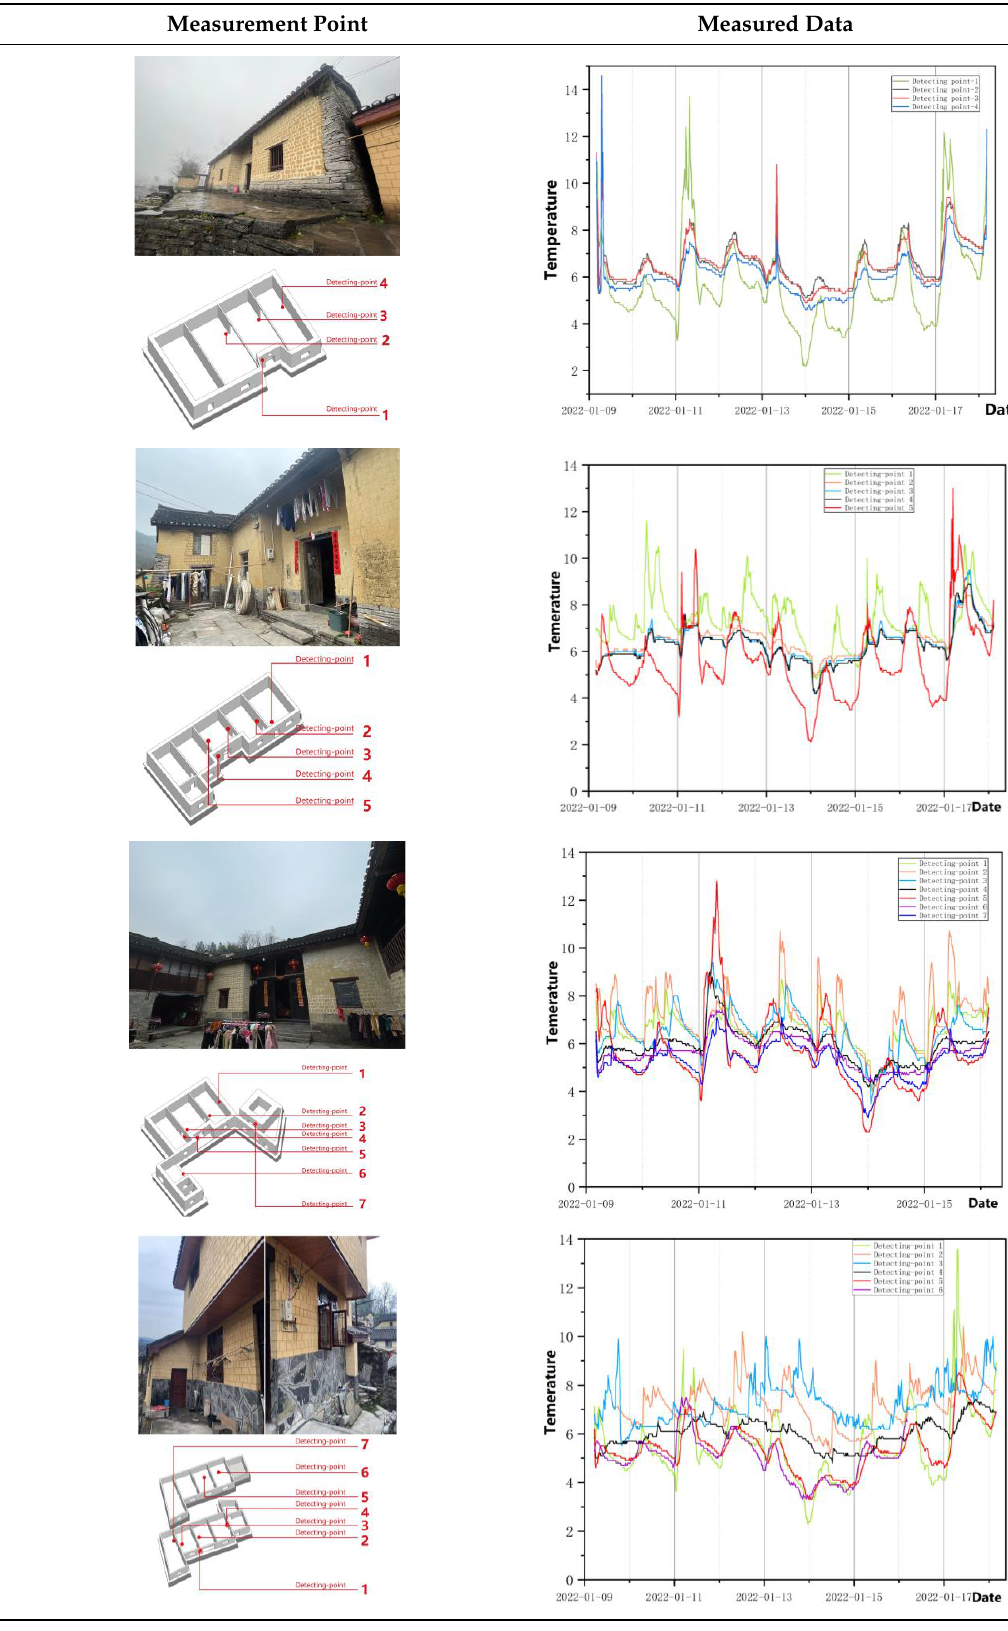
Table 4. Winter temperature detection.